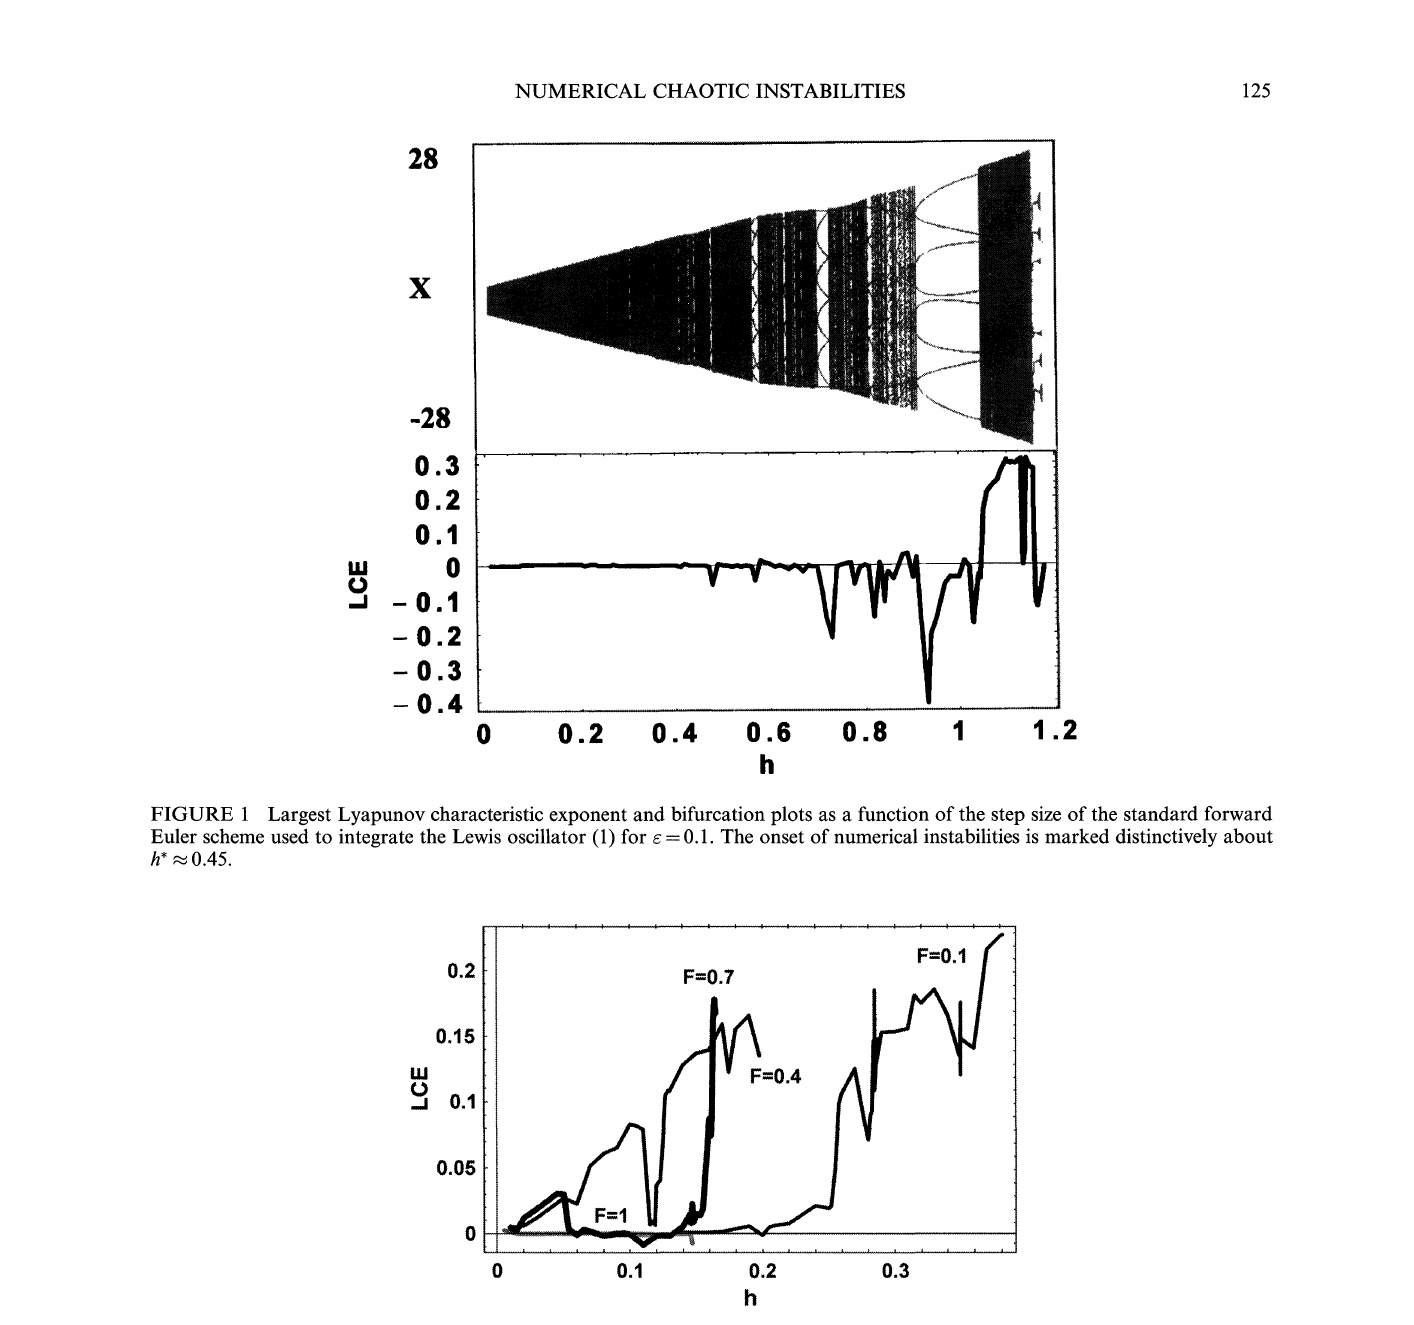
0 0.1 0.2 0.3 h FIGURE 2 Largest Lyapunov characteristic exponent as a function of the step size of the standard forward Euler scheme used to integrate the two-well Duffing oscillator (3) for various values ofthe amplitude ofthe driving force. For F=0.1 (where a limit cycle is expected) is clearly observed the numerical induction of chaos at h* 0.16. In contrast, for F=0.7 (where a chaotic regime is expected) it is shown a numerically suppression of chaos at h* 0.05, followed at h** 0.14 by a numerical transition periodicity/ chaos similar to that for